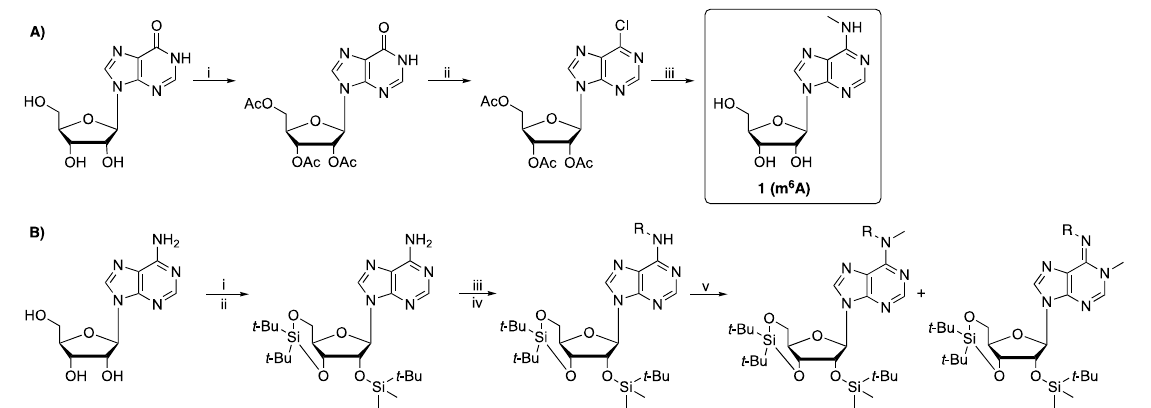
Scheme 1. Previous strategies towards synthesis of (protected) m 6 A. ( A ) Route involving the Vilsmeier reagent [8]. Reaction conditions: (i) acetic anhydride (5.7 eq), pyridine, dimethylformamide (DMF), 75 °C, 0.5 hr; (ii) Vilsmeier reagent (2